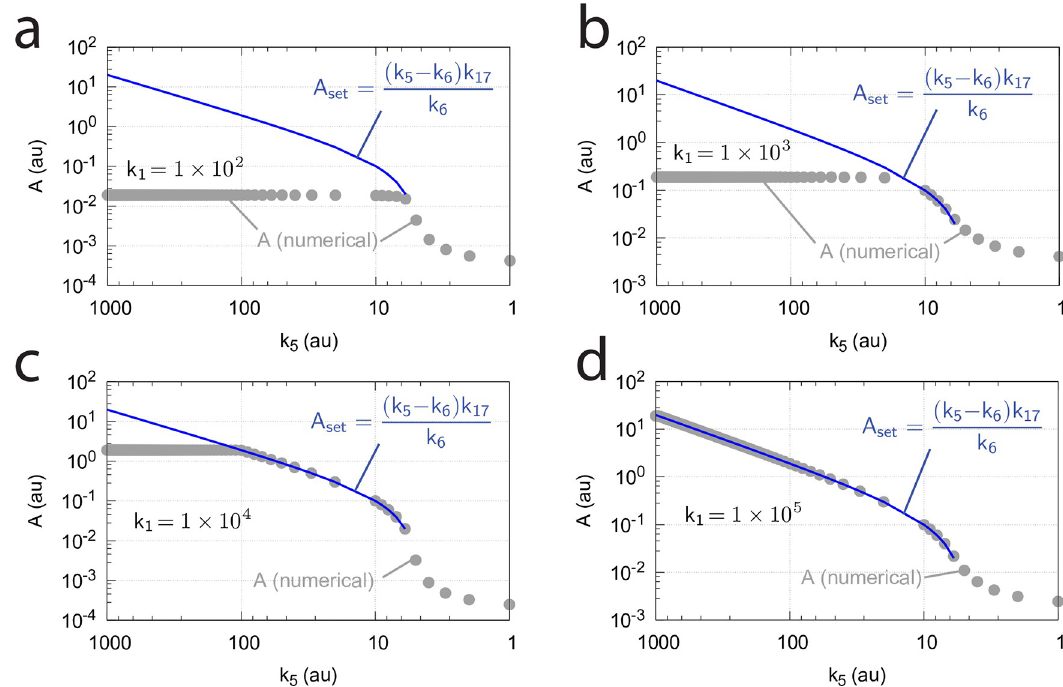
Fig 58. Influence of k 1 on the operational range of the m7 ternary-complex controllers. The results using the scheme of Fig 56b are shown. (a)